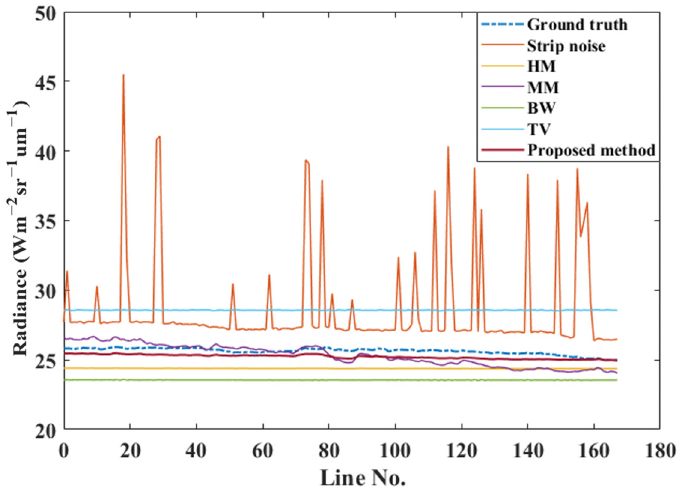
Figure 11. Correction results for the MMS V ‐ NIR (central wavelength of 950.9 nm) simulation data from linear stretched images. Original V ‐ NIR image (left) and an image with strip noise (second from the left). Correction results based on the different algorithms for the simulated images shown: